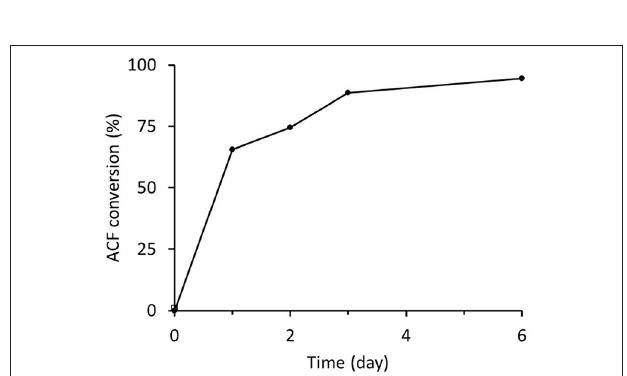
FIGURE 6 | Bioreduction of ACF to 1-phenylethanol in soluble RrADH and FDH